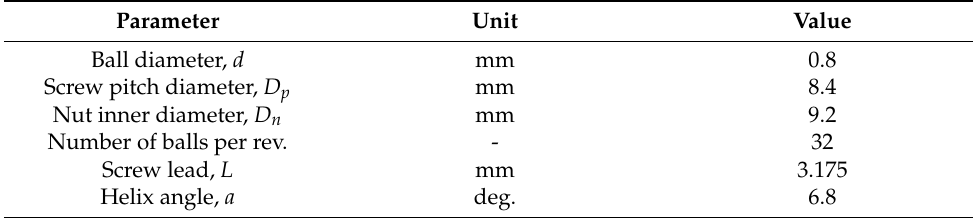
Figure 7. The FLEA test stand. Table 1. Ball-screw geometry